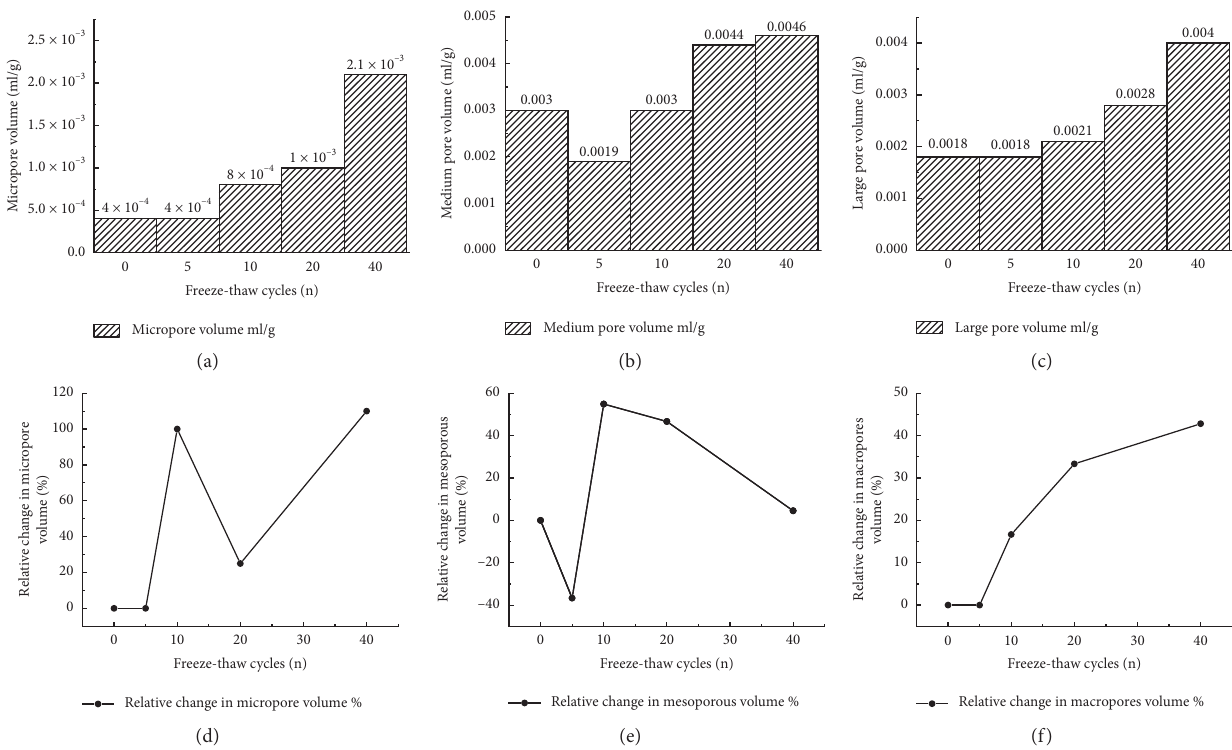
Figure 9: Pore volume and relative change amplitude of A in yellow sandstone under freeze-thaw cycles. (a) Micropore volume. (b) Mesoporous volume. (c) Macropores volume. (d) Relative change in micropore volume. (e) Relative change in mesoporous volume. (f) Relative change in macropores